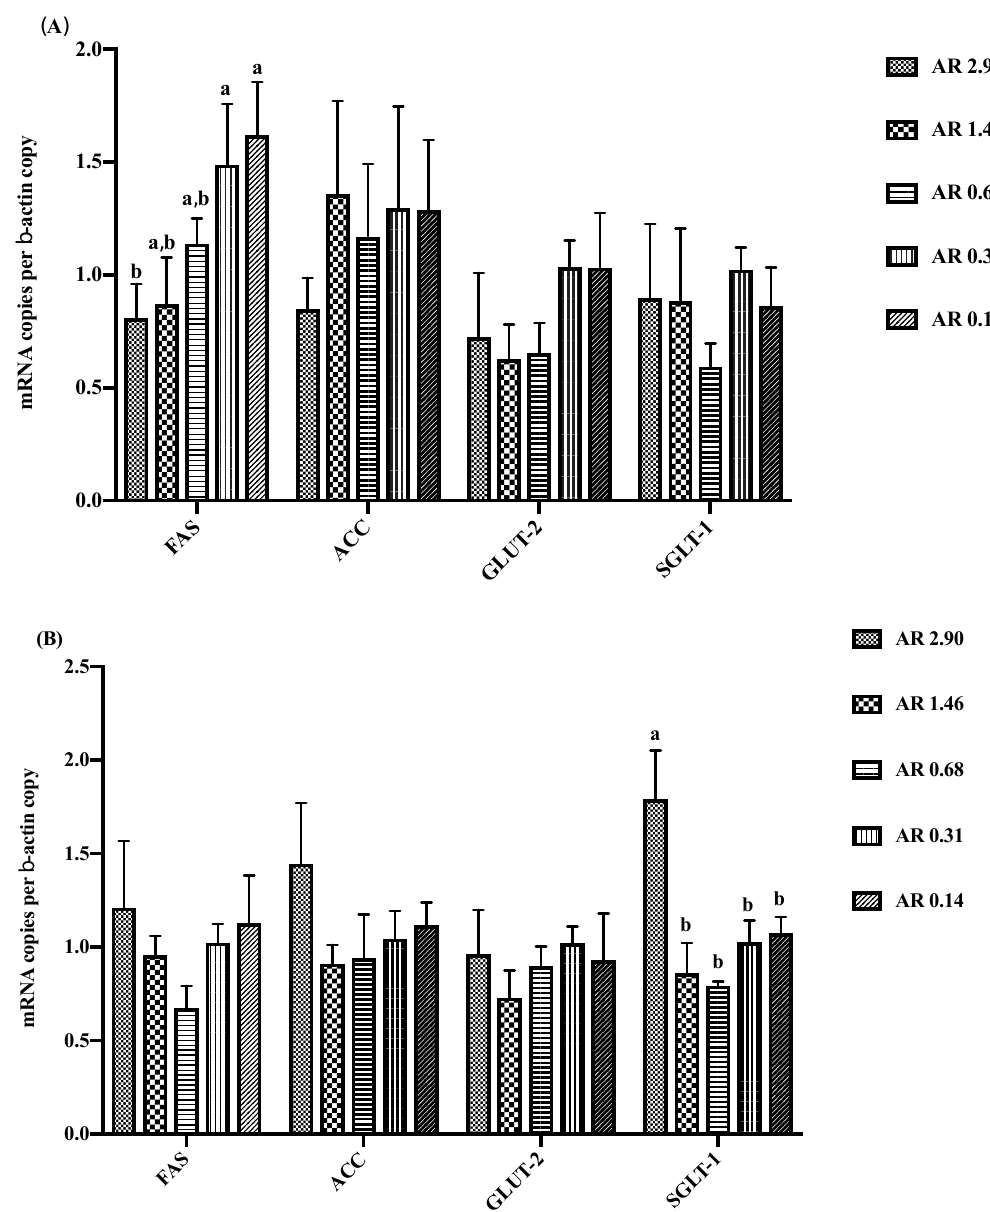
Figure 1. Effects of dietary starch structure on intestinal gene expression in the duodenum ( A ) and jejunum ( B ). FAS , fatty acid synthase; ACC , acetyl CoA carboxylase; GLUT-2 , glucose transporter type 2; SGLT-1 , sodium-dependent glucose transporter 1. Values are means, with standard errors represented by vertical bars ( n = 6). a, b Mean values with unlike letters were significantly different within a cluster of bars, not across the clusters of bars ( p < 0·05).